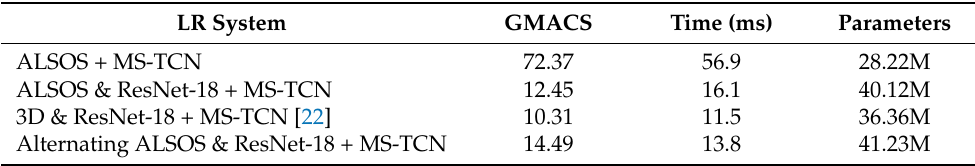
Table 1. Number of operations and processing time for LR